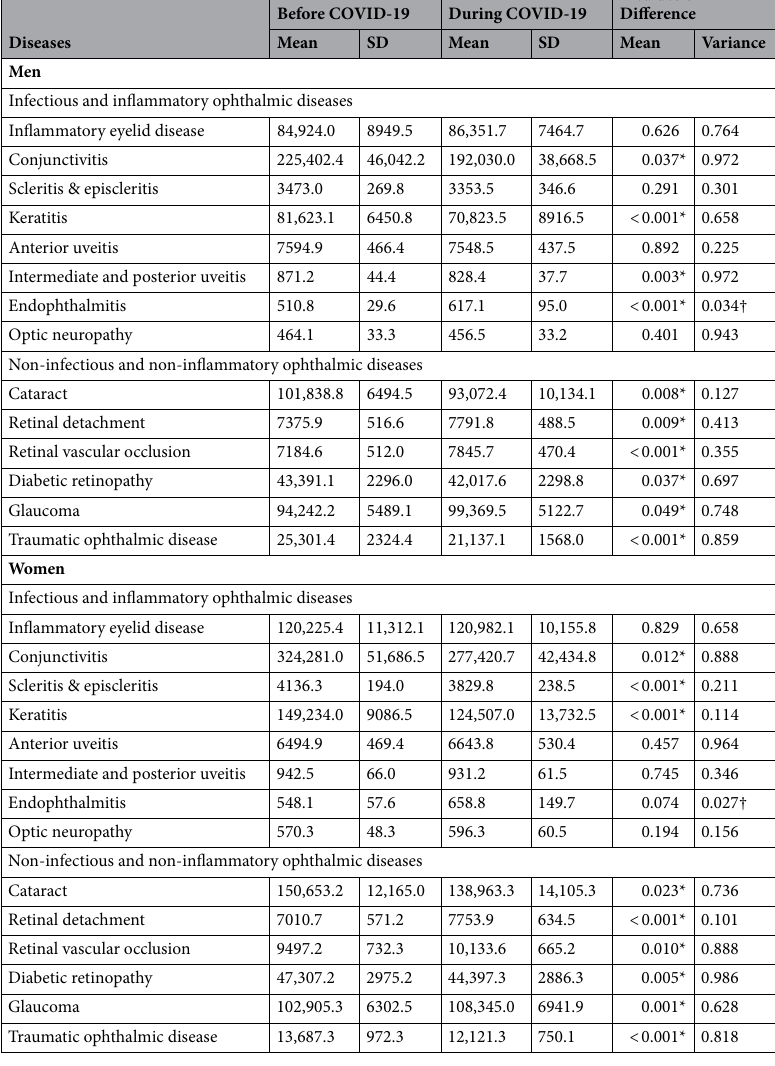
Table 2. Means, standard deviations of disease incidence before and during COVID-19 and their differences by sex. * Mann Whitney U test, significance at < 0.05. †Levene’s test for non-parametric data, significance at <